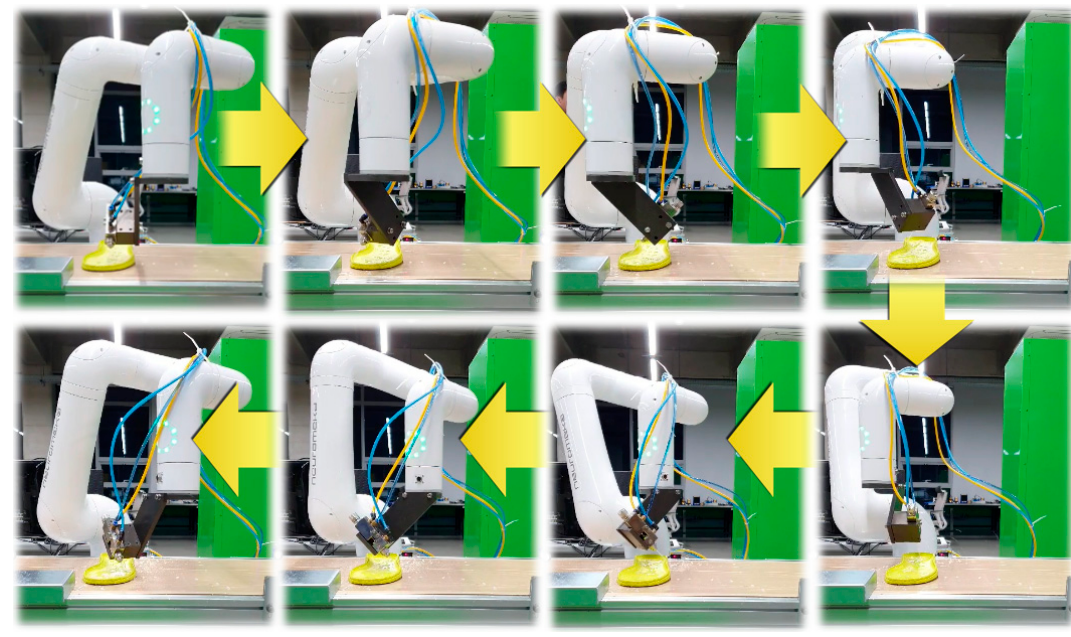
Figure 21. Adhesive dispensing test of shoe midsole.